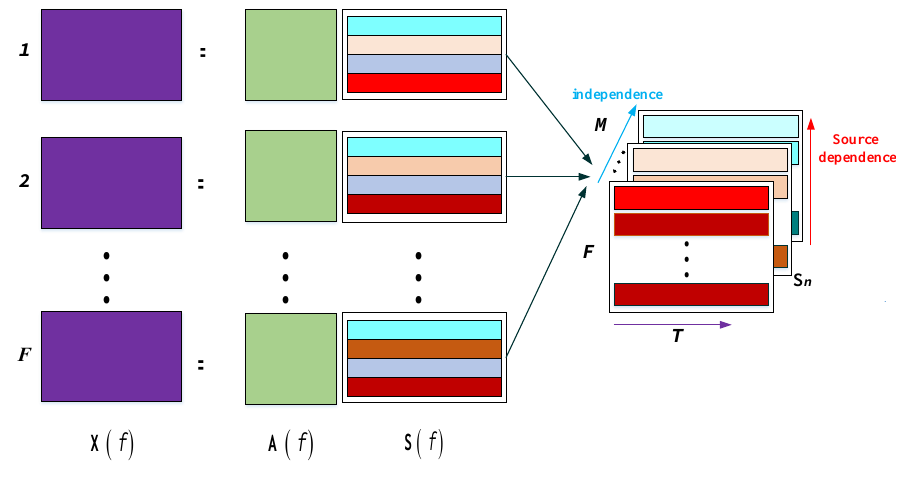
Figure 5. IVA structure based on